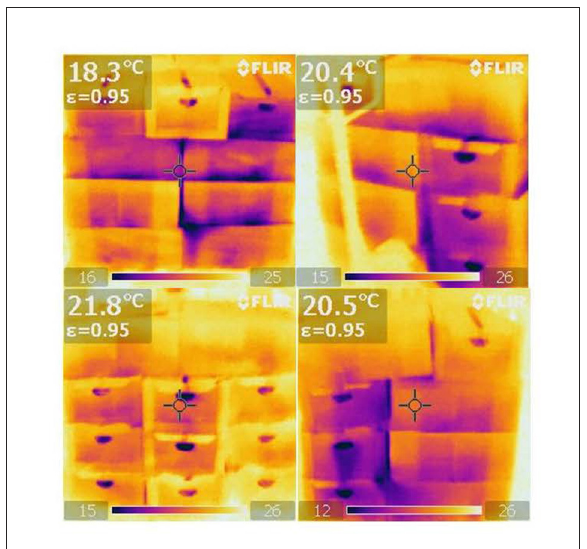
FIGURE8 Thermal images of all sides of a pallet of chicken breasts after 24h of cyclic TA (2h at 4 ◦ C then 2h at 25 ◦